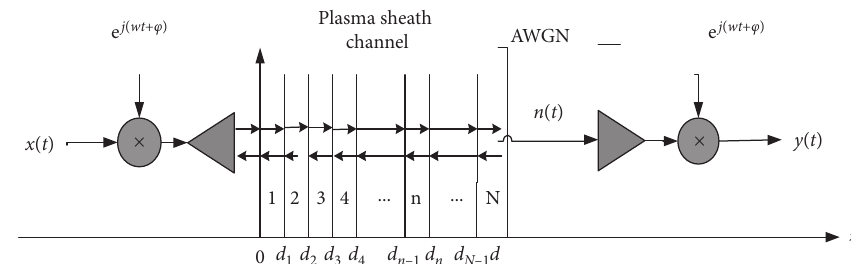
Figure 2: Layered schematic diagram of plasma sheath.